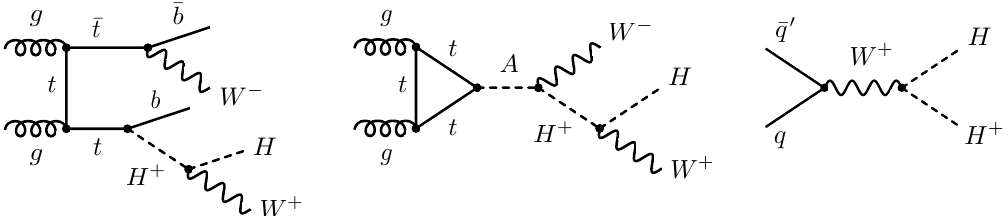
Figure 1 . Exotic H production channels through cascades or in association with a charged Higgs. The left Feynman diagram shows the process gg ! t (cid:22) t followed by t ! H + b ( H + ! W + H ), the middle graph illustrates the reaction gg ! A with A ! W (cid:0) H + ( H + ! W + H ), while the diagram on the right corresponds to the transition q (cid:22) q 0 ! W + ! H + H